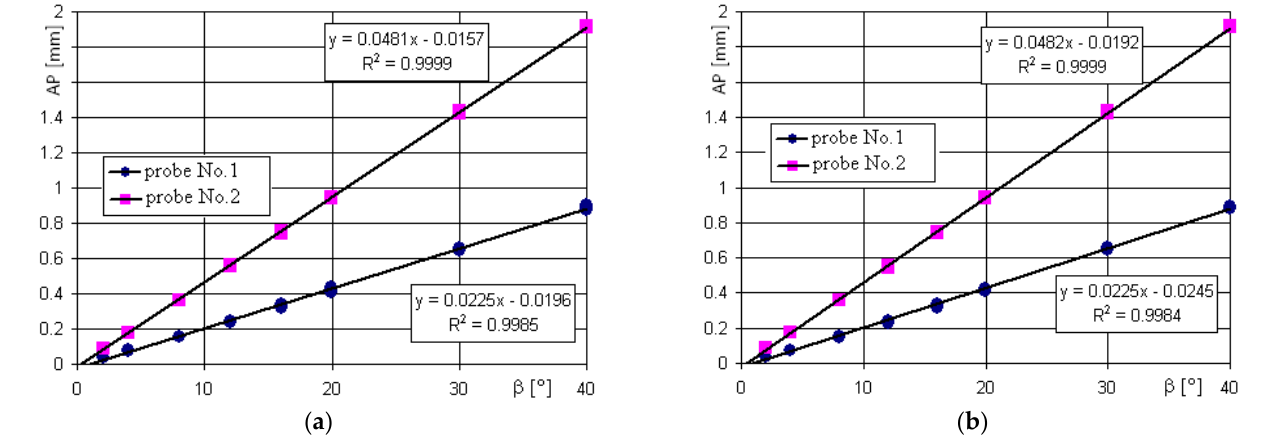
Figure 7. Positioning accuracy AP at different angles β for Probe 1 ( ∅ 2 mm) and Probe 2 ( ∅ 5 mm). The measured samples were: ( a ) Sample 1 out of steel; ( b ) Sample 2 out of granite.